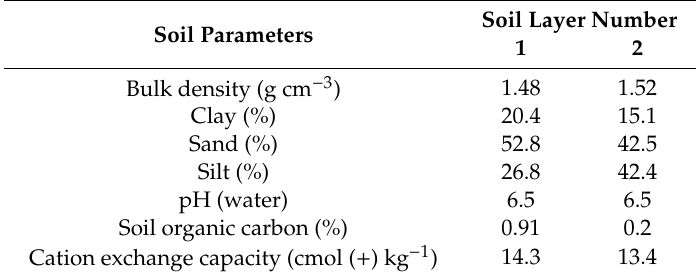
Figure 1. Map of Africa showing South Africa and the location of the Cradock Research Farm within the Great Fish River System. Table 1. Selected soil properties and depths of the soil profile used as input into the Environmental Policy Integrated Climate (EPIC) model at Cradock Research Farm